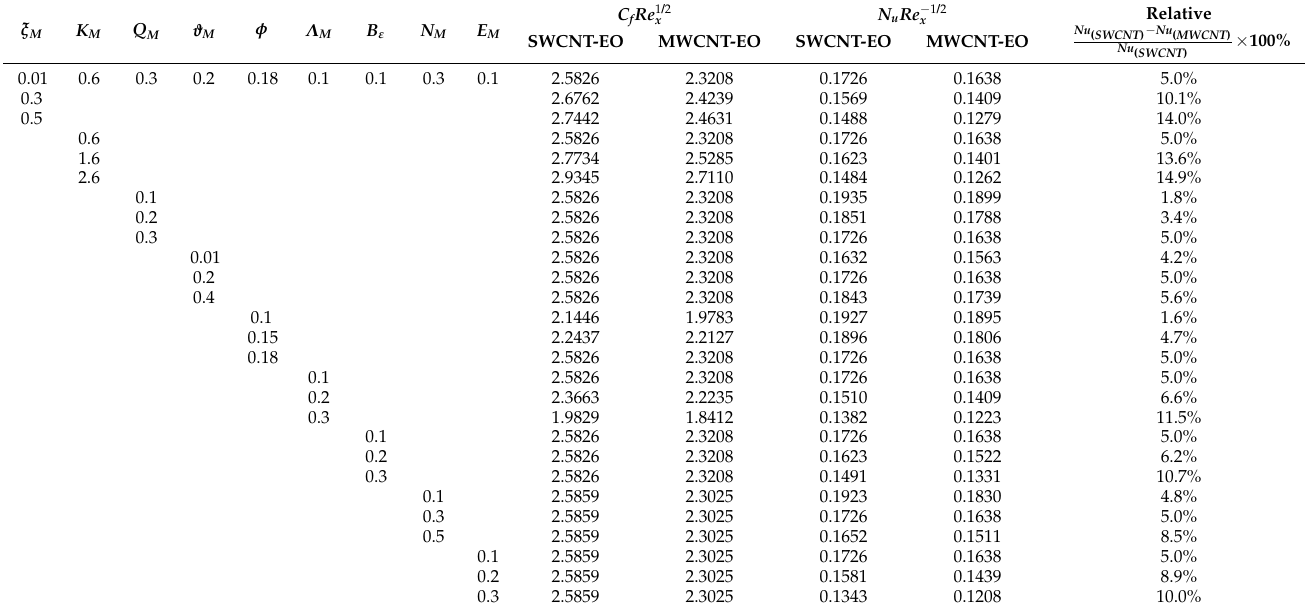
Table 4. Skin friction ( C f Re 1/2 x ) and Nusselt Number ( N u Re − 1/2 x ) values for Pr =